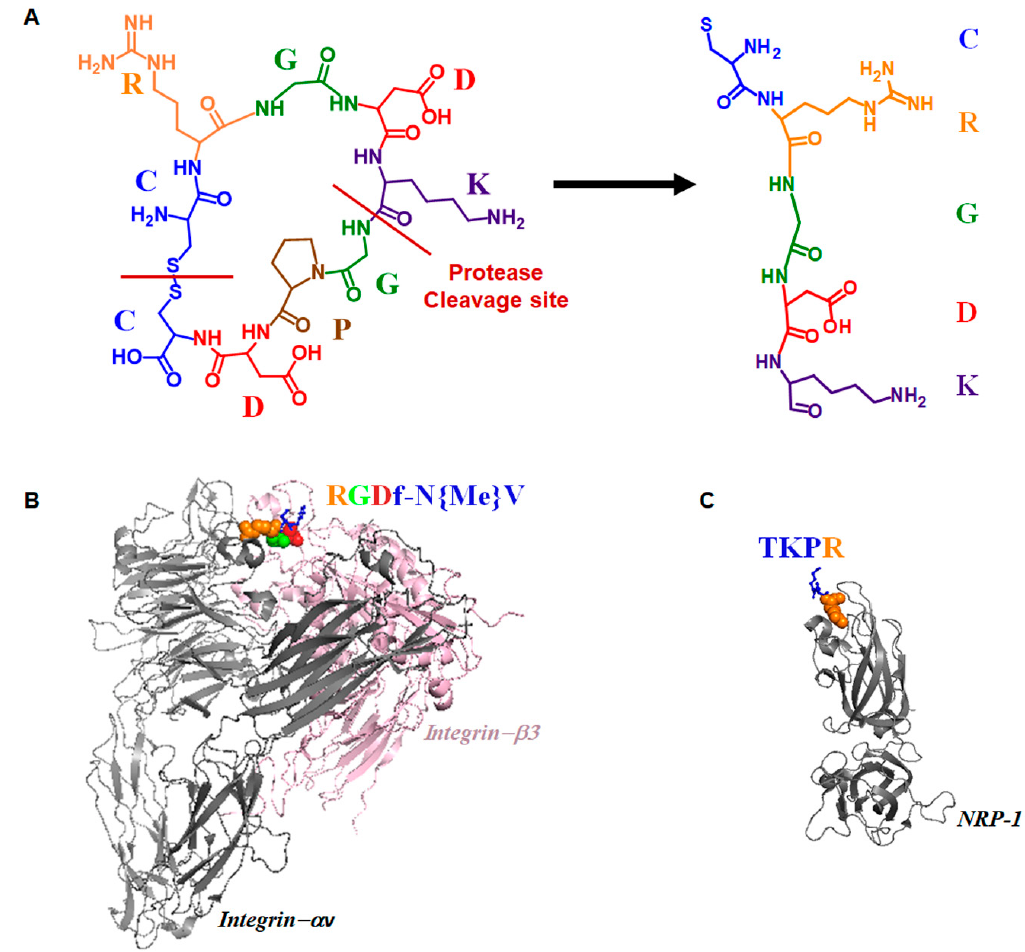
Figure 1. Illustration of cleavage process and the binding events of cyclic iRGD [CRGDKGPDC] peptide. ( A ) iRGD is proteolytically cleaved to expose the cryptic C-end Rule (CendR) motif. The cleavage sites are indicated with red lines. ( B ) iRGD binds with integrins. As an example, we present the structure of integrin α v β 3 complexed with cyclo (RGDf-NV) reproduced from PDB code 1I5G [68]. ( C ) After cleavage, the arginine or lysine of the CendR motif binds to the b1 domain of neuropilin-1 (NRP-1). The presented structure was reproduced from PDB code 2ORZ showing the binding event of NRP-1 and Tuftsin mediated by arginine moiety [55,69,70]. The spheres represent the binding residues of polypeptides and blue ball-sticks represent non-binding residues. The color indicates the corresponding sequence of peptides.